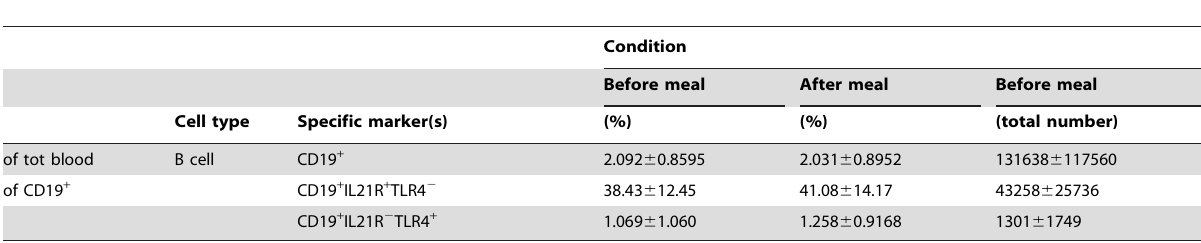
Table 4. Peripheral blood B cells. Data is displayed as mean 6 standard deviation.